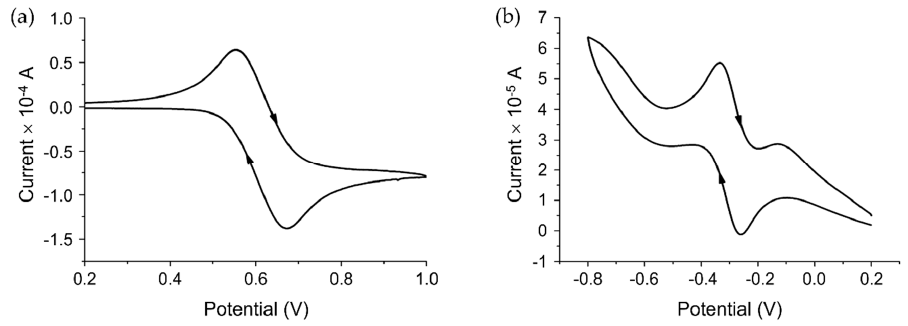
Figure2. Cyclicvoltammogramsof( a )[Ru(II)Cl 2 (DMSO) 2 (Hapbim)]( 1 )and( b )[Ru(III)Cl 3 (DMSO)(Hapbim)] Figure 2. Cyclic voltammograms of ( a ) [Ru(II)Cl 2 (DMSO) 2 (Hapbim)] ( 1 ) and ( b ) [Ru(III)Cl 3 (DMSO)(Hapbim)] ( 2 ). Concentration 10 − 3 M, in the CH 2 Cl 2 /DMSO solution with 0.1 M ( 2 ). Concentration 10 − 3 M, in the CH 2 Cl 2 / DMSO solution with 0.1 M (Bu 4 N)PF 6 , scan rate 50 mVs − 1 . (Bu 4 N)PF 6 , scan rate 50 mVs − 1 .